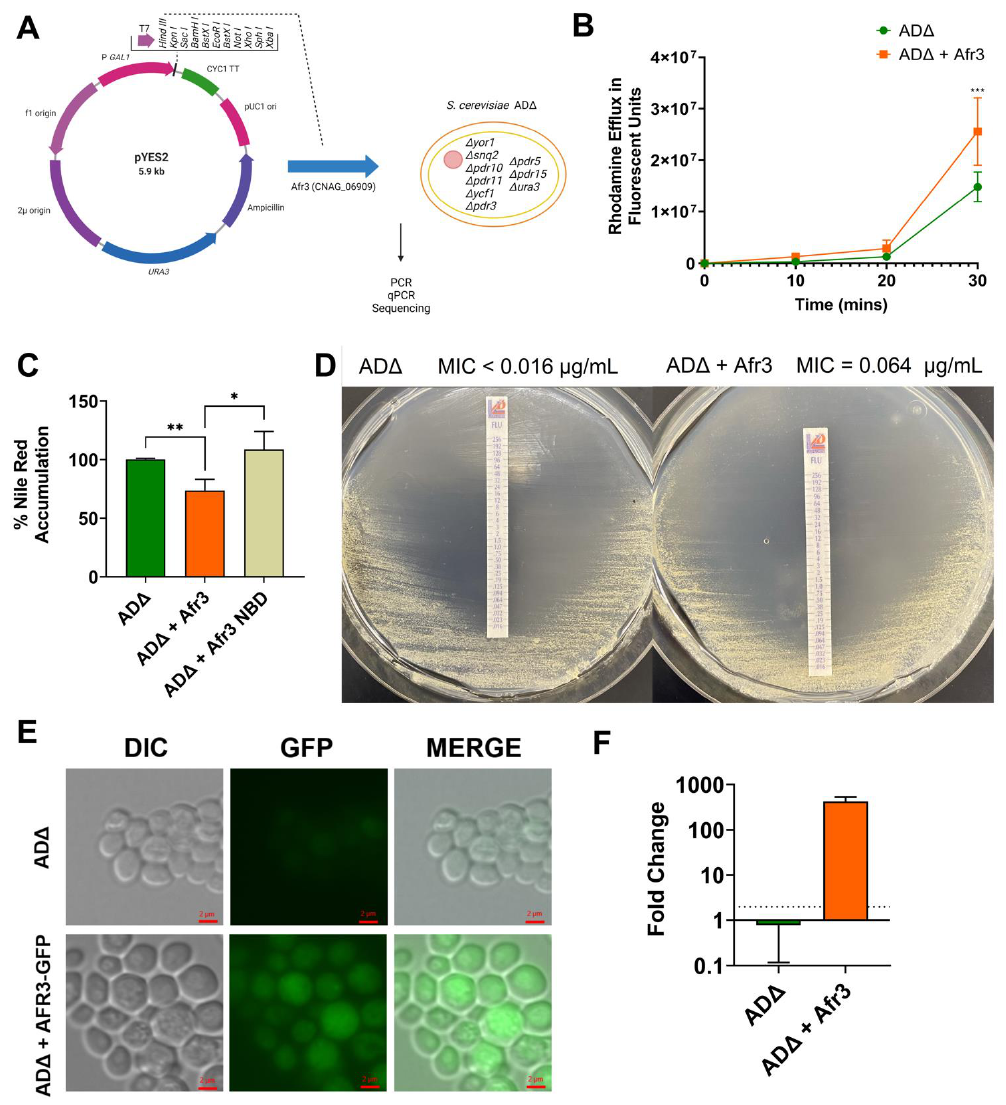
Figure 3. Afr3 Expression in Saccharomyces cerevisiae Increases Efflux and FLC Resistance. ( A ) Schematic diagram of Afr3 expression in S. cerevisiae ADΔ strain. The pYES2 plasmid contains a URA3 auxotrophic marker gene, a 2 µ origin of replication, a GAL1 promoter, and a CYC1 terminator. Hind III was used as the cloning site between the GAL1 promoter and CYC1 terminator. AFR3 ( CNAG_06909 ) cassette was inserted in this cloning site when transformed into S. cerevisiae AD ∆ strain. The transformation was confirmed through plasmid PCR, qPCR for AFR3 expression, and sequencing of the AFR3 cassette. The figure was designed with BioRender. All subsequent experiments were performed at 30 ◦ C; ( B ) AD ∆ + Afr3 (orange line) shows increased efflux when compared to AD ∆ (green line) when measured employing the Rhodamine 6G dye; ( C ) AD ∆ + Afr3 (orange bar) has lower intracellular accumulation of Nile Red when compared to control AD ∆ (green bar). A catalytically inactive NBD mutant of Afr3 (yellow bar) does not show a statistical difference in Nile Red accumulation from AD ∆ ; ( D ) a FLC E-Test strip assay shows that expression of Afr3 increases the strain resistance to FLC (MIC of 0.064 µ g/mL vs. <0.016 µ g/mL); ( E ) S. cerevisiae AD ∆ cells expressing AFR3 -GFP show protein expression by means of GFP fluorescence. Brightfield and epifluorescence images were obtained that were later superimposed; ( F ) AFR3 expression in AD ∆ is 425-fold higher (orange bar) than the control (green bar) as measured by qPCR. Error bars represent the standard deviation between biological triplicates. Statistical analysis was performed with multiple unpaired Student’s t -test, * p < 0.05, ** p < 0.01, *** p <